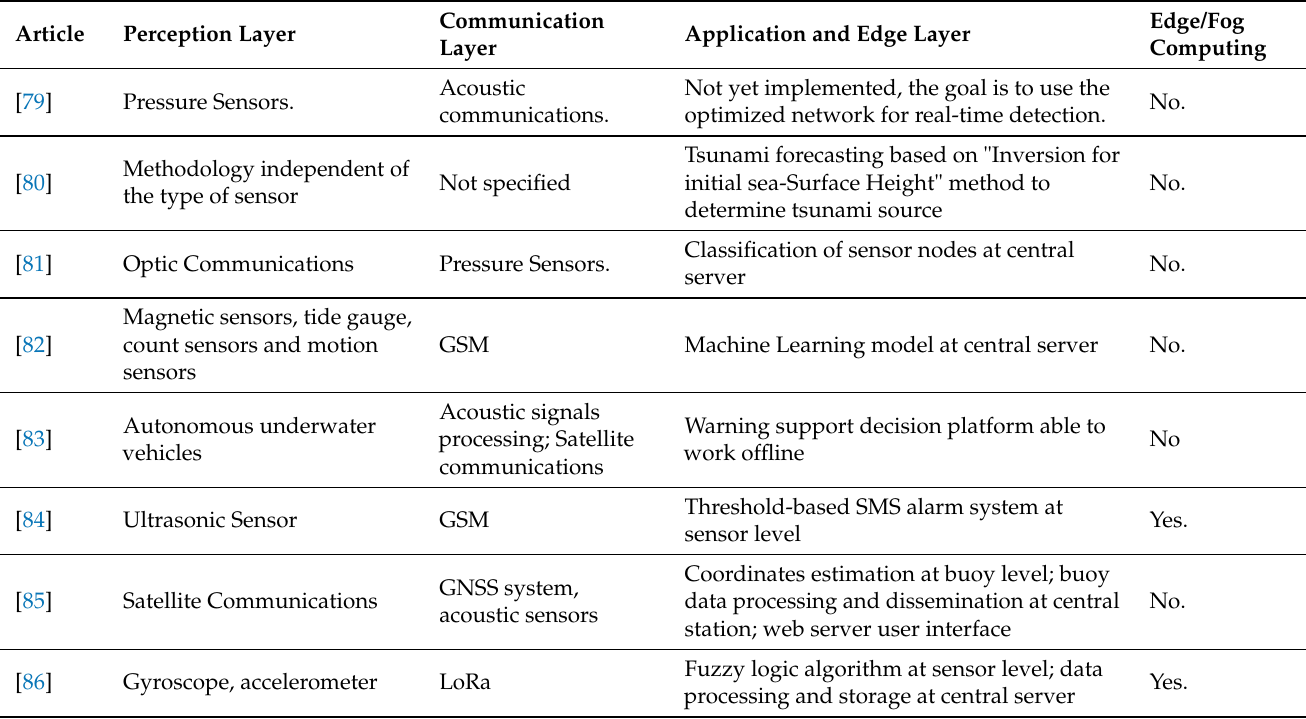
Table 6. Technologies and solutions used for each layer by the reviewed papers for Tsunami